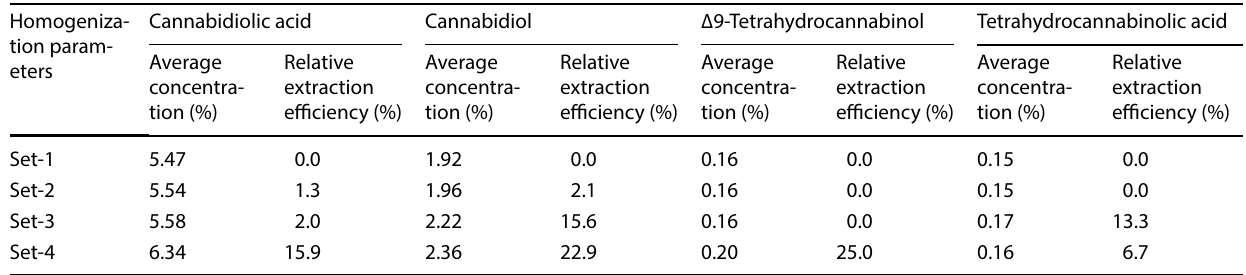
Table 2 Overall extraction efficiency of major cannabinoids based off homogenization parameters